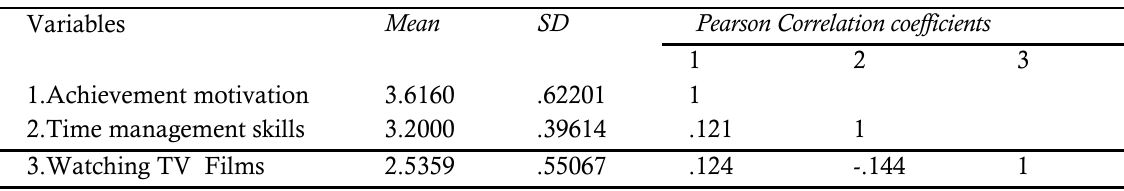
Table 2. Correlation Among Watching TV Films, Time Management Skills and